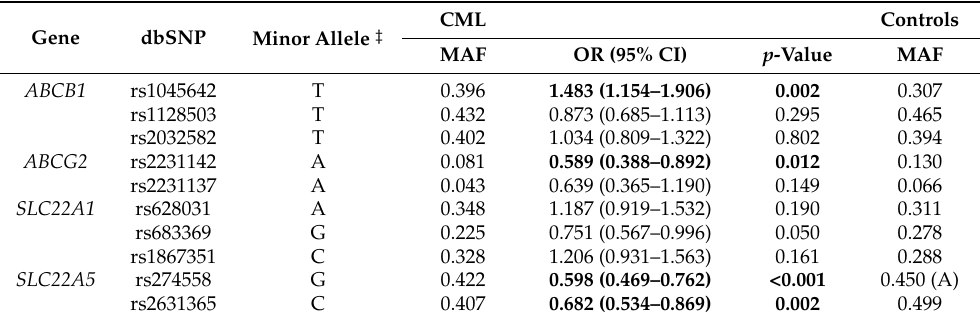
‡ Minor allele according 1000 Genome database (Caucasians/European/Iberian population in Spain). Bold indicates statistically significant association. MAF: minor allele frequency; OR: odds ratio; CI: confidence interval; CML: chronic myeloid